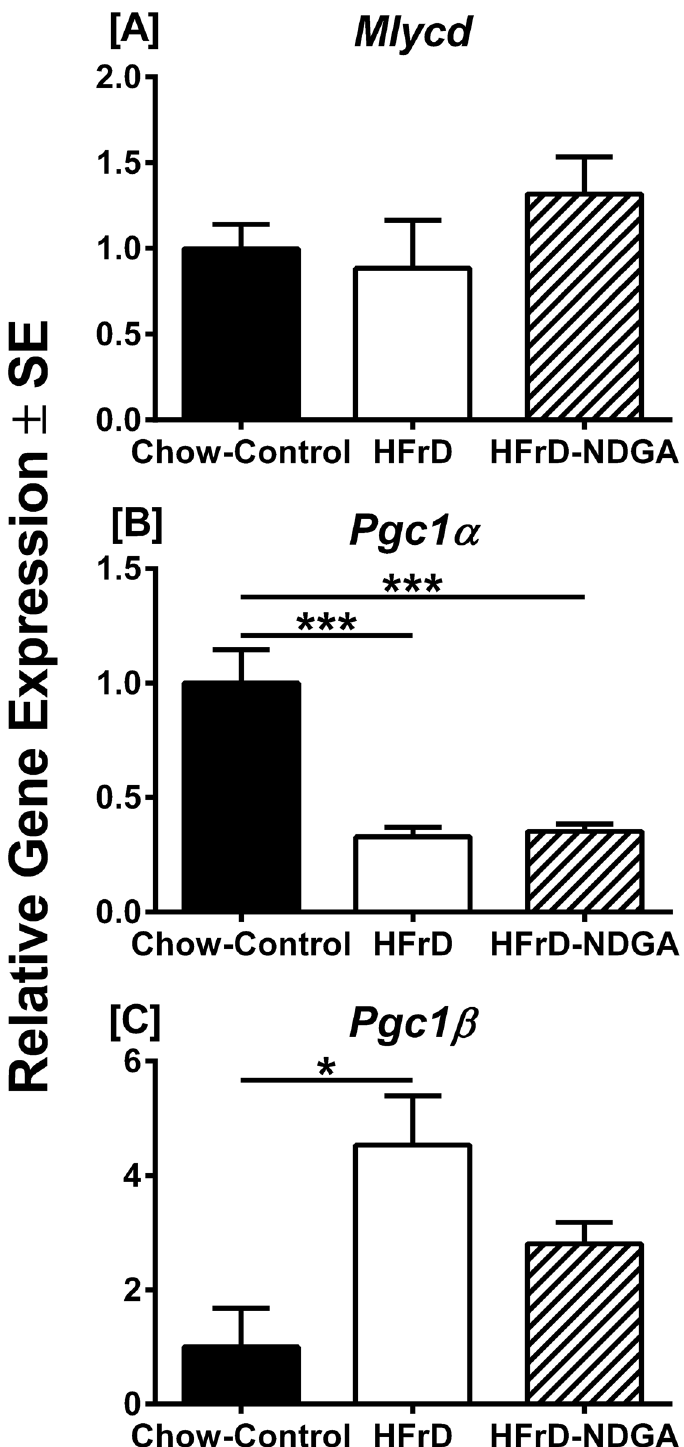
Fig 4. Effect of NDGA treatment on expression of Mlycd, Pgc-1 α and Pgc-1 β . Quantitative RT-PCR of RNA from livers of chow-fed rats, rats fed an HFrD for 8 weeks and rats fed an HFrD for 8 weeks and subsequently treated with NDGA at a dose of 125 mg/kg BW twice a day by oral gavage. Results are mean ± SE of 3 independent RT-PCR experiments for each gene within each group (normal chow, n = 3, high fructose n = 4, high fructose with NDGA n = 4). Data are presented relative to 36B4 in the same samples,